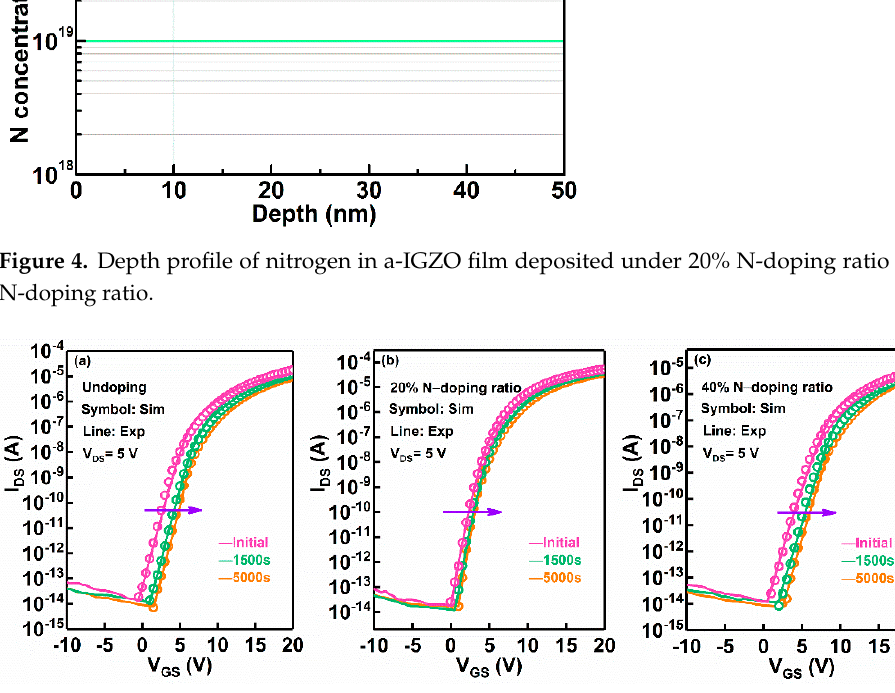
Figure 5. Simulated transfer characteristics against positive bias stress (PBS) time for the a-IGZO TFTs fabricated with different N-doping ratios: ( a ) undoped, ( b ) 20% N-doping ratio, and ( c ) 40% N-doping ratio.